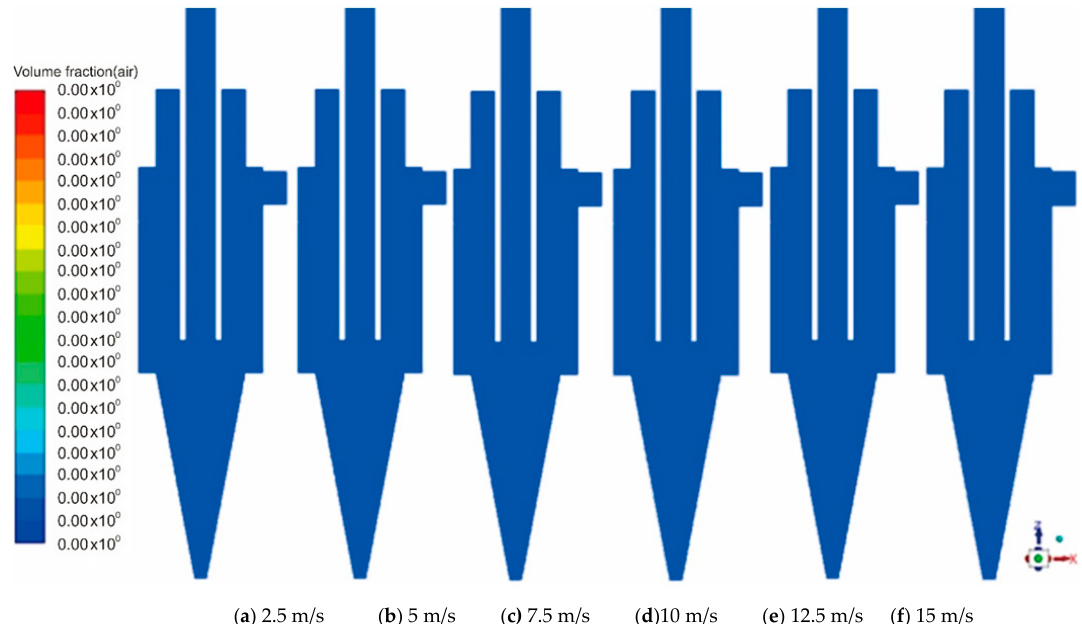
Figure 10. Contours of air column in the plane y = 0 mm inside the TPHS with different inlet velocity at the simulation time of 10 s: ( a ) 2.5 m/s, ( b ) 5 m/s, ( c ) 7.5 m/s, ( d )10m/s, ( e ) 12.5 m/s and ( f ) 15 m/s